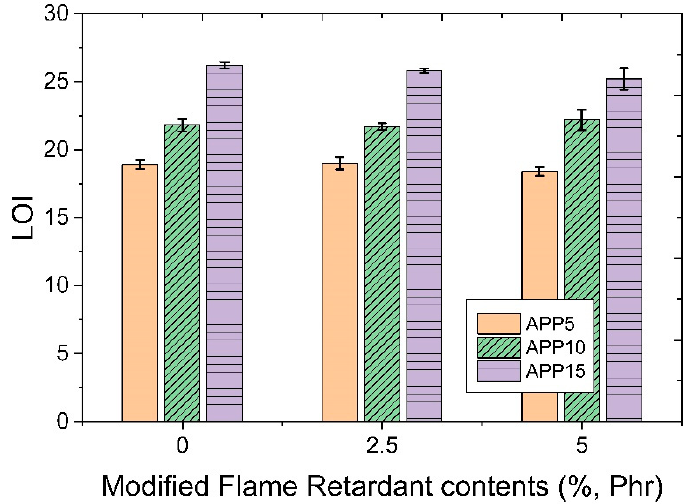
Figure 12. LOI measurement results as a function of the amount of modified flame retardant and APP added.